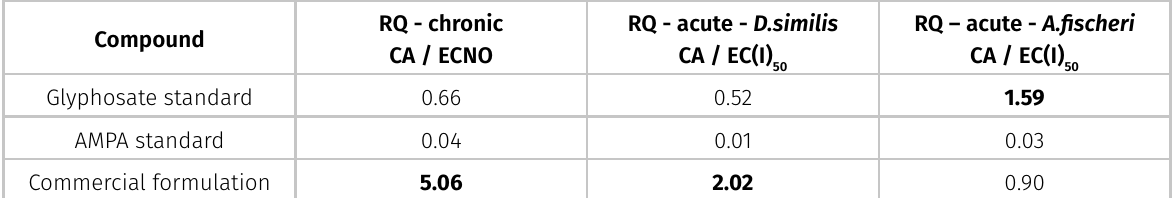
Table IV. Risk quotient results (RQ); Compound